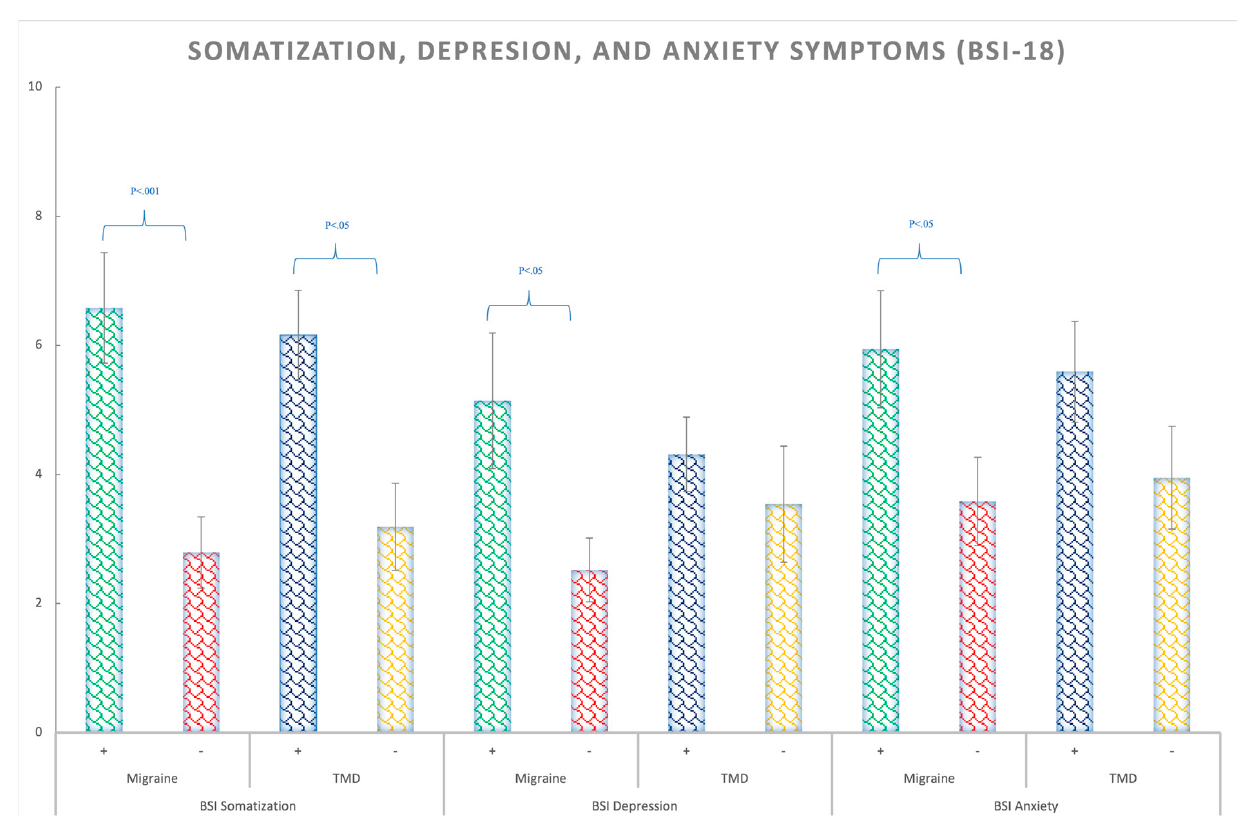
Figure 3. BSI-18 means scores for the somatization, depression, and anxiety symptoms in Migraine (+, − ) and TMD (+, − ) patients. Bars represent standard errors.